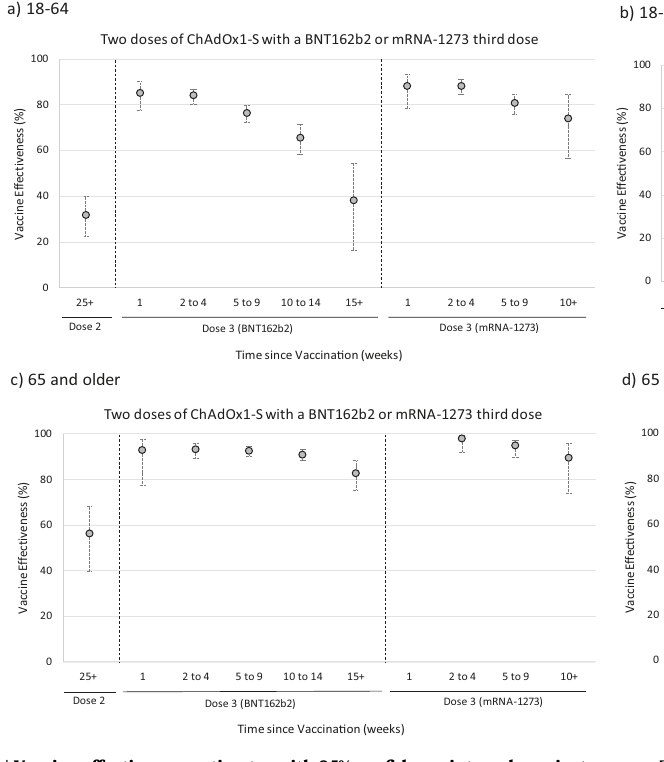
or mRNA-1273 third dose, Vaccine effectiveness estimates are adjusted using sex, indexofmultiple deprivation(quintile),ethnicgroup,carehomeresidence status (for age 65+),geographic region (NHSregion), period(calendar weekofthetest), health and social care worker status (for age <65), clinical risk group status (for age <65), clinically extremely vulnerable, severely immunosuppressed, and pre- viously tested